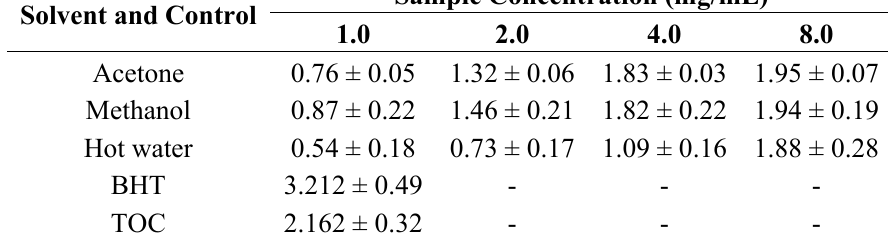
Table 2. Reducing power of different concentrations of various extracts from the fruiting bodies of Pleurotus florida